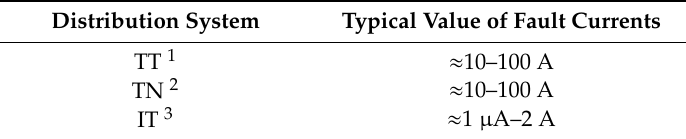
Figure 1. Parallel and series arc faults. AFDD: Arc fault detection device, L: line, N: neutral, PE: Earth Protective conductor. Table 1. Ground fault currents during electrical faults [12].